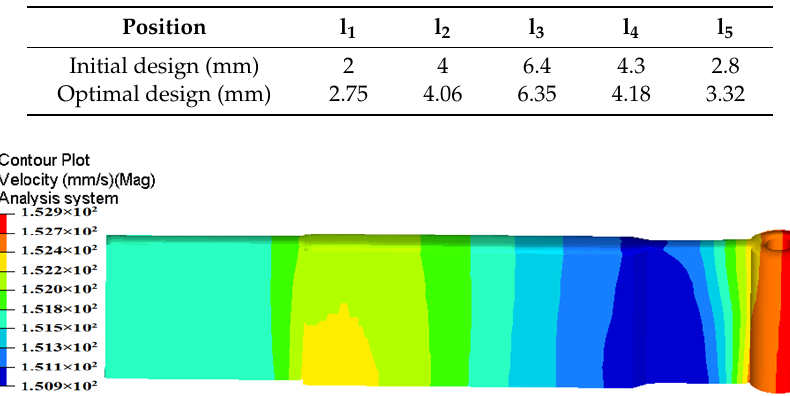
Figure 15. Velocity distribution of extruded profile with adjusting bearing lengths.